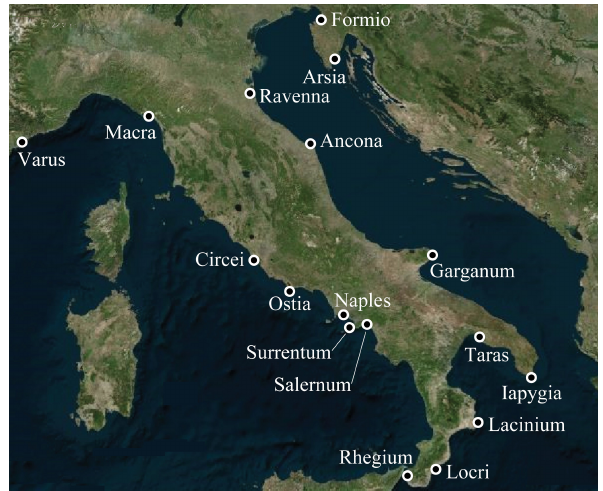
Figure 8. Pliny’s points of the coast of Italy on the modern